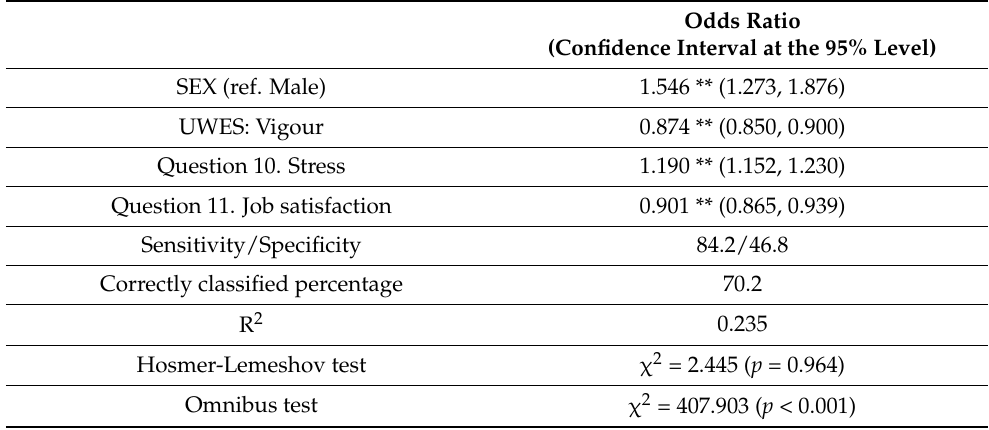
Table 6. Binary logistic regression results for psychological distress ( N = 2161). Odds Ratio (Confidence Interval at the 95% Level) SEX (ref. Male) 1.546 ** (1.273, 1.876) UWES: Vigour Question 10. Stress Question 11. Job satisfaction Sensitivity/Specificity 84.2/46.8 Correctly classified percentage 70.2 R 2 0.235 Hosmer-Lemeshov